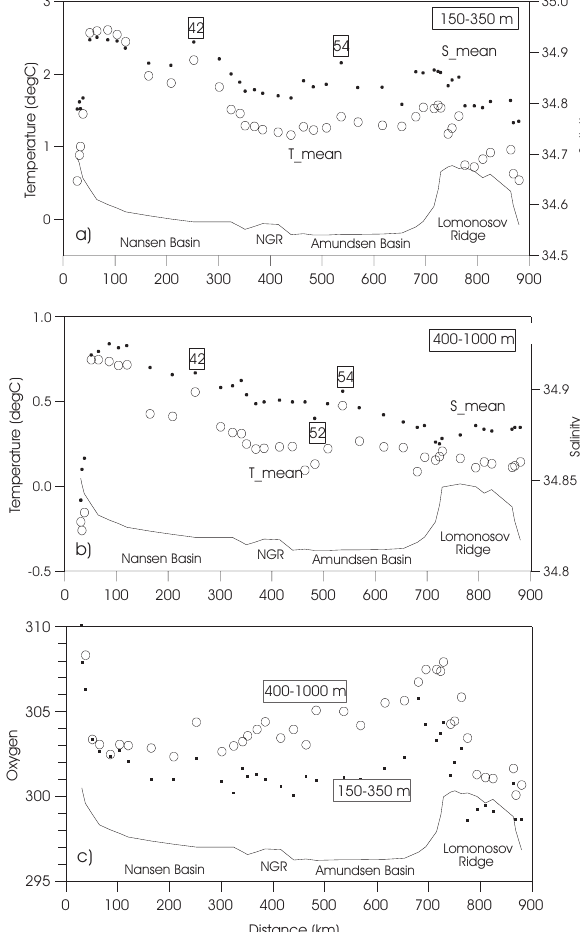
Fig. 7. Cross-basin distribution of vertically averaged values from stations 29 to 72 (see Fig. 1) (a) temperature and salinity in the core layer of the Fram Strait Branch Water (FSBW) (150–350m), (b) temperature and salinity in the layer of the Barents Sea Branch Water (BSBW) (400–1000m), (c) oxygen ( µ mol/kg) in the layers 150 to 350m and 400 to 1000m, respectively. The line at the bottom shows the water depth (NGR: Nansen Gakkel